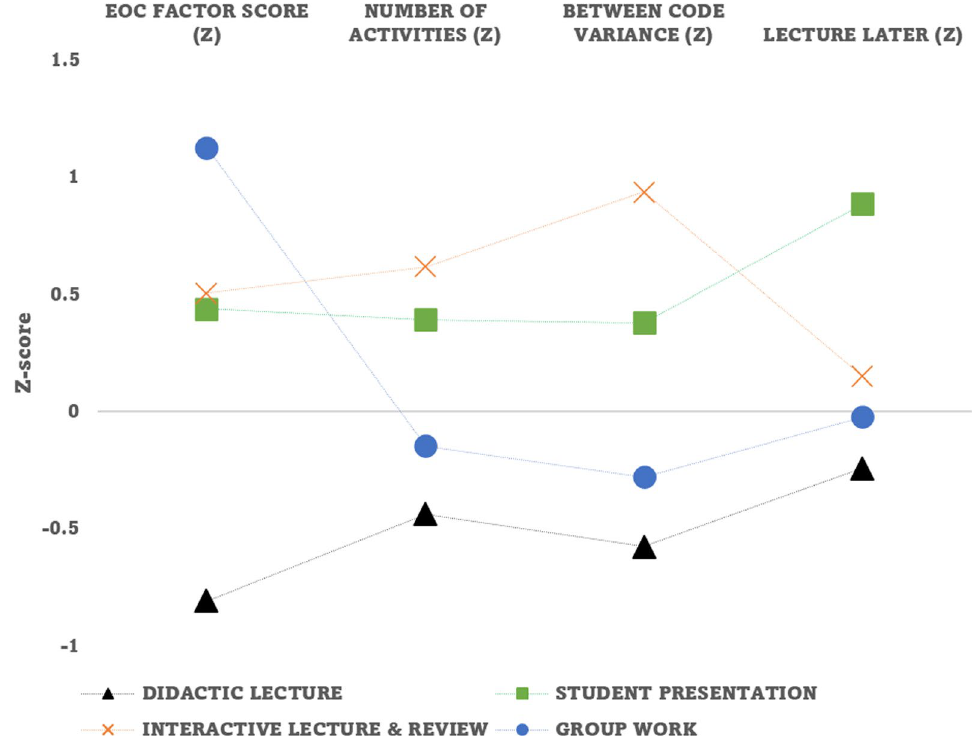
Fig. 2 Profiles of four LPA groups on global